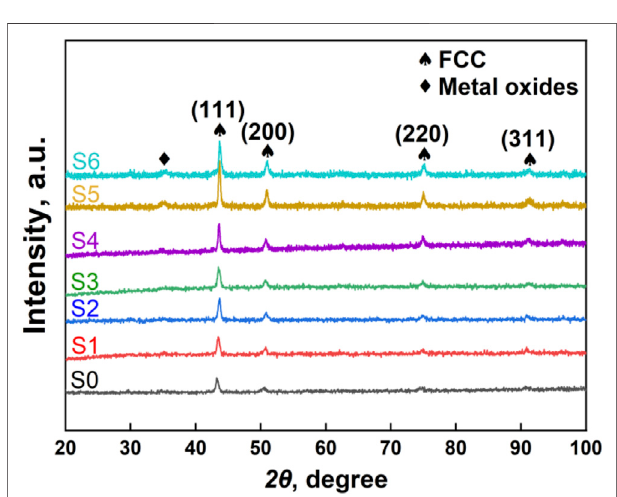
FIGURE 4 | XRD patterns of the CoCrFeNiMn HEA coatings before and after transient thermal shock tests.